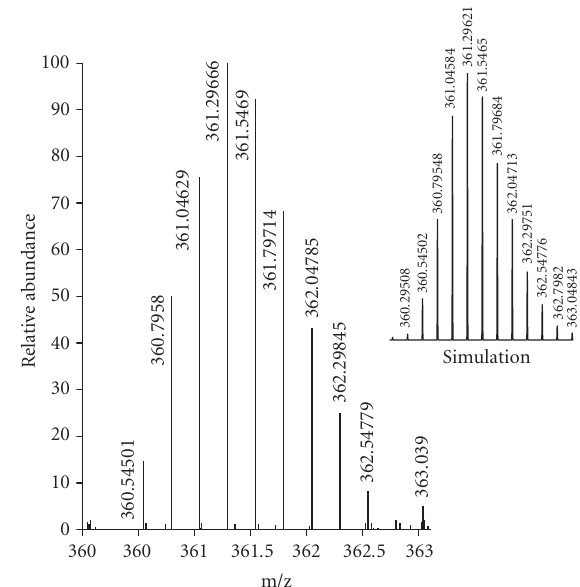
Figure 6: HRMS spectrum of complex 4 : Observed and calculated